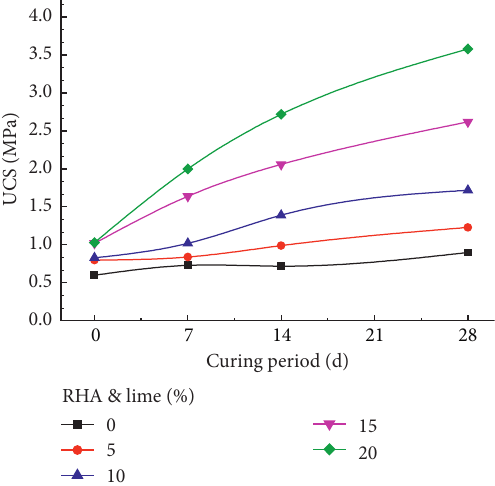
Figure 6: The UCS of soil with 40% water content.